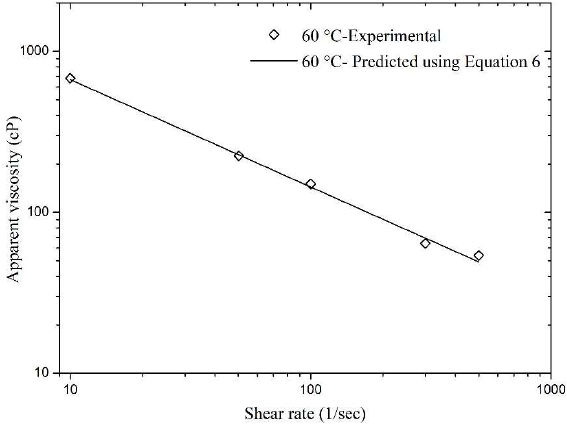
Figure 5. Validation of Equation (6).